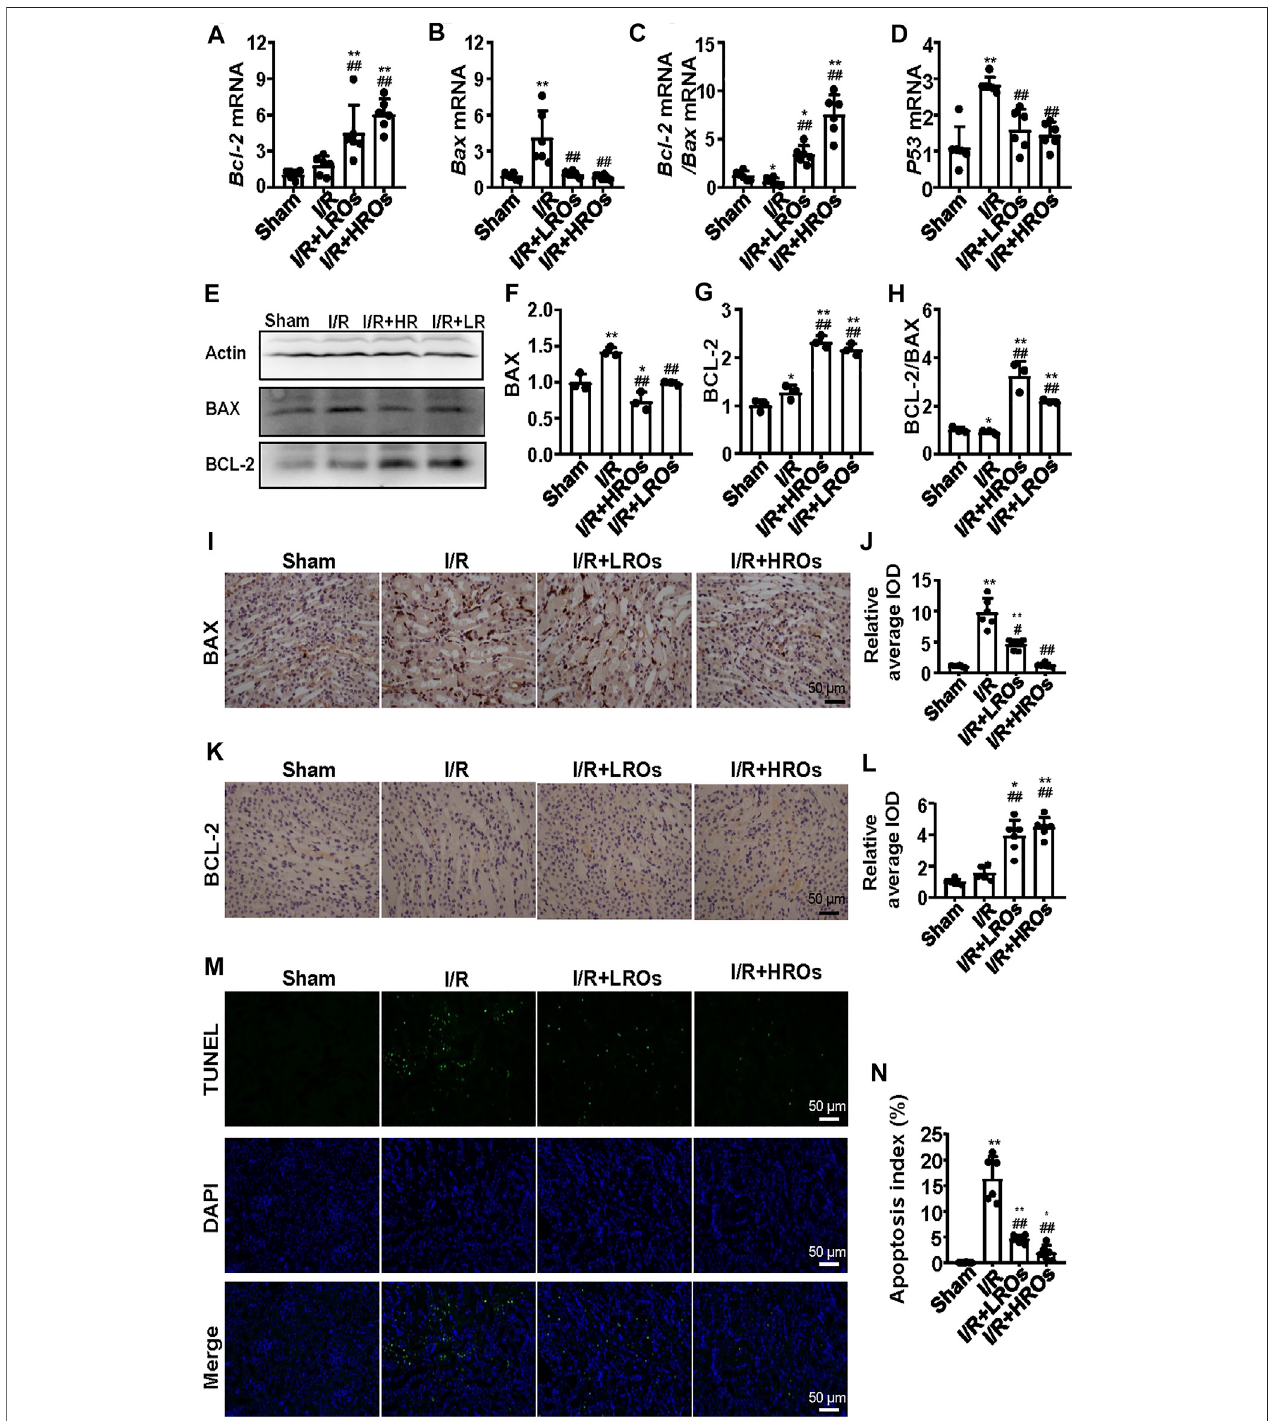
FIGURE3| SuppressionofI/R-inducedapoptosiswithriclinoctaose. (A,B) RelativemRNAexpressionof Bax (A)and Bcl-2 (B)inthekidneysoftheshamgroup,I/R group, I/R + LROs group, and I/R + HROs group. (C) The ratio of Bcl-2 and Bax gene expression levels. (D) mRNA level of p53 in the kidneys of the four groups. (E – G) Western blot and densitometric quantitation of BAX and BCL-2 in kidneys of four groups. (H) The ratio of BCL-2 and BAX protein levels. (I, J) Representative immunohistochemistry sections (I) and quantitative results (J) of BAX staining. (K, L) Representative immunohistochemistry sections (K) and quantitative results (L) of BCL-2 staining. (M) TUNEL-stain (green) indicates apoptosis-positive cells; DAPI stain (blue) indicates nucleated cells; the “ merge ” row shows cells stained with TUNELandDAPI. (N) QuantitativeresultsofTUNELpositivecells.ROs:Riclinoctaose.Dataareexpressed asmean ± SD. n (cid:1) 6forQRT-PCR, n (cid:1) 3forwesternblotting. * p < 0.05, ** p < 0.01 compared with the sham group; # p < 0.05, ## p < 0.01 compared with the I/R group. Data were analyzed by the two-way ANOVA followed by Bonferroni post hoc analysis.